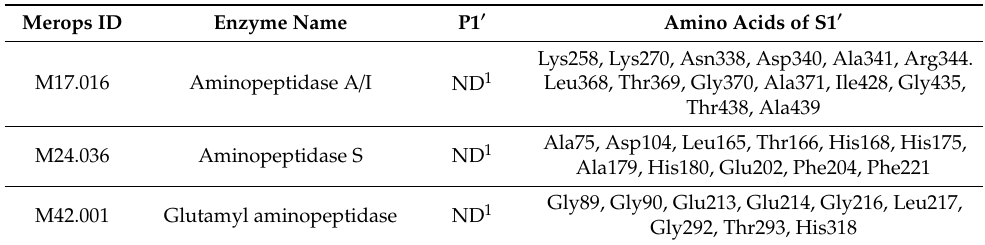
Table 6. Selected bacterial aminopeptidases with the P1 (cid:48) -preferred amino acid in the S1 (cid:48) binding pocket with residues forming the cavity.